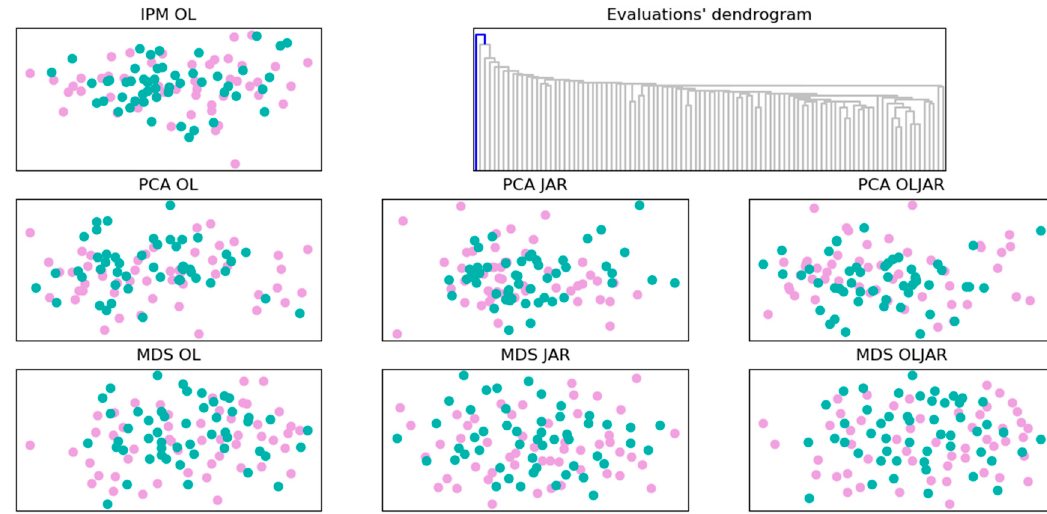
Figure 7. Experiment 2. Consumers’ segments; pink and green points represent women and men consumers, respectively.